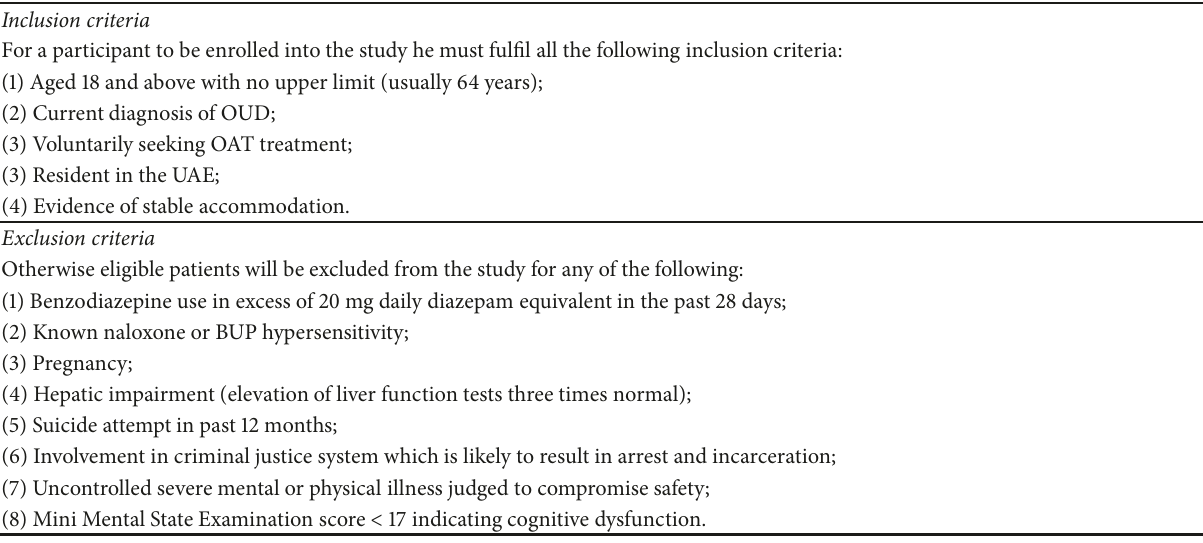
Table 1: Participant inclusion and exclusion